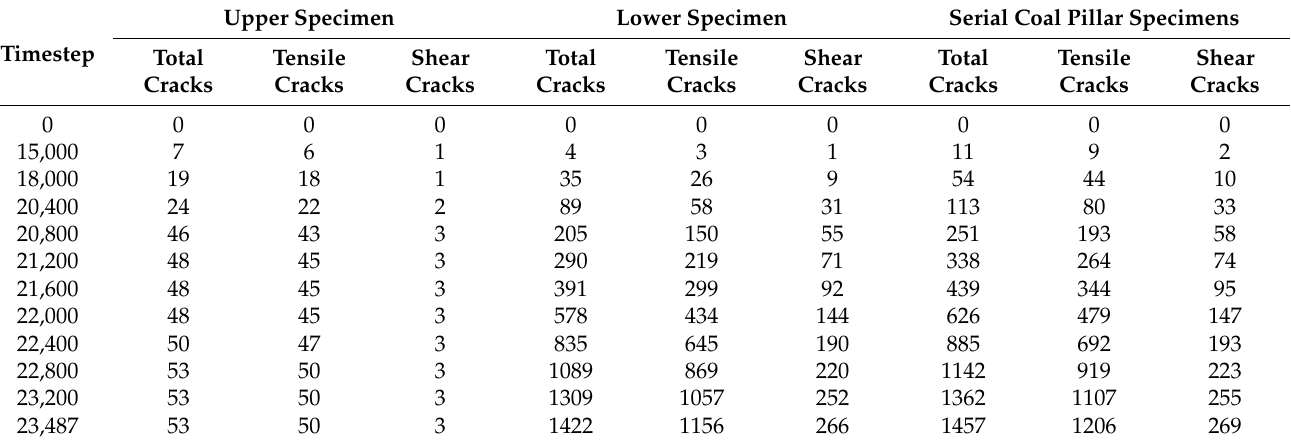
Figure 13. Evolution curve of crack number of serial coal pillar specimens. Table 4. Evolution of crack number of serial coal pillar specimens at the remarkable